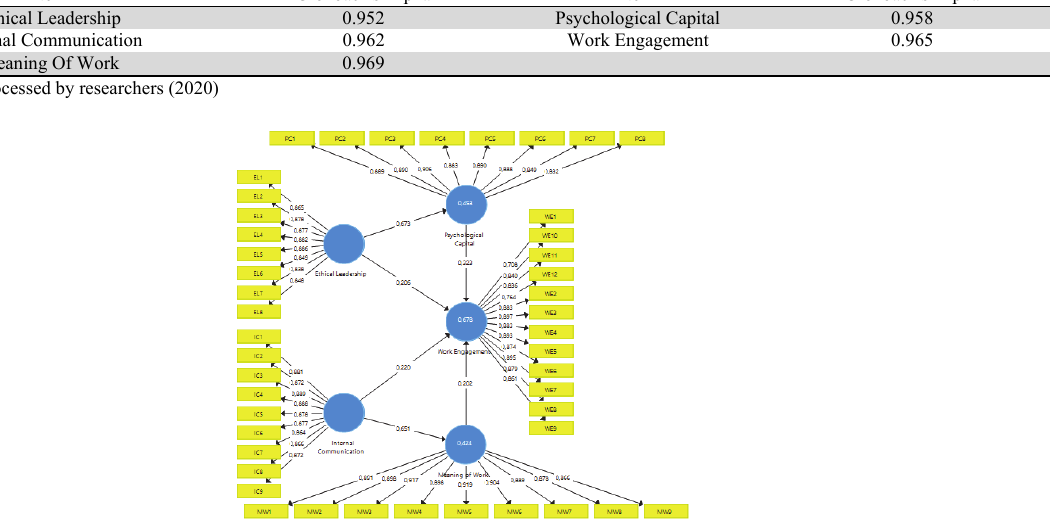
Fig. 1. Outer Model Source: data processed by researchers (2020)